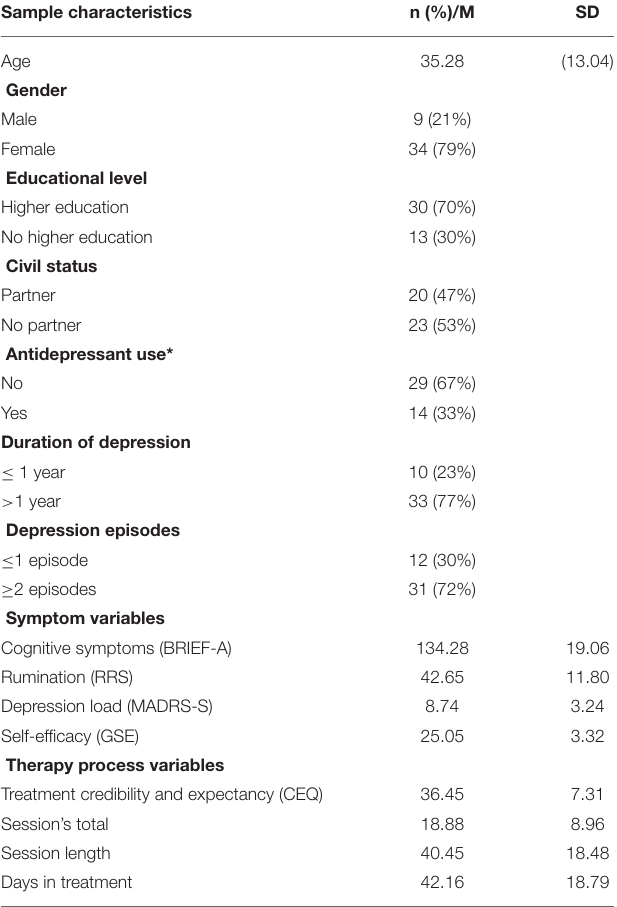
TABLE 4 | Characteristics of the study sample ( N = 43). Sample